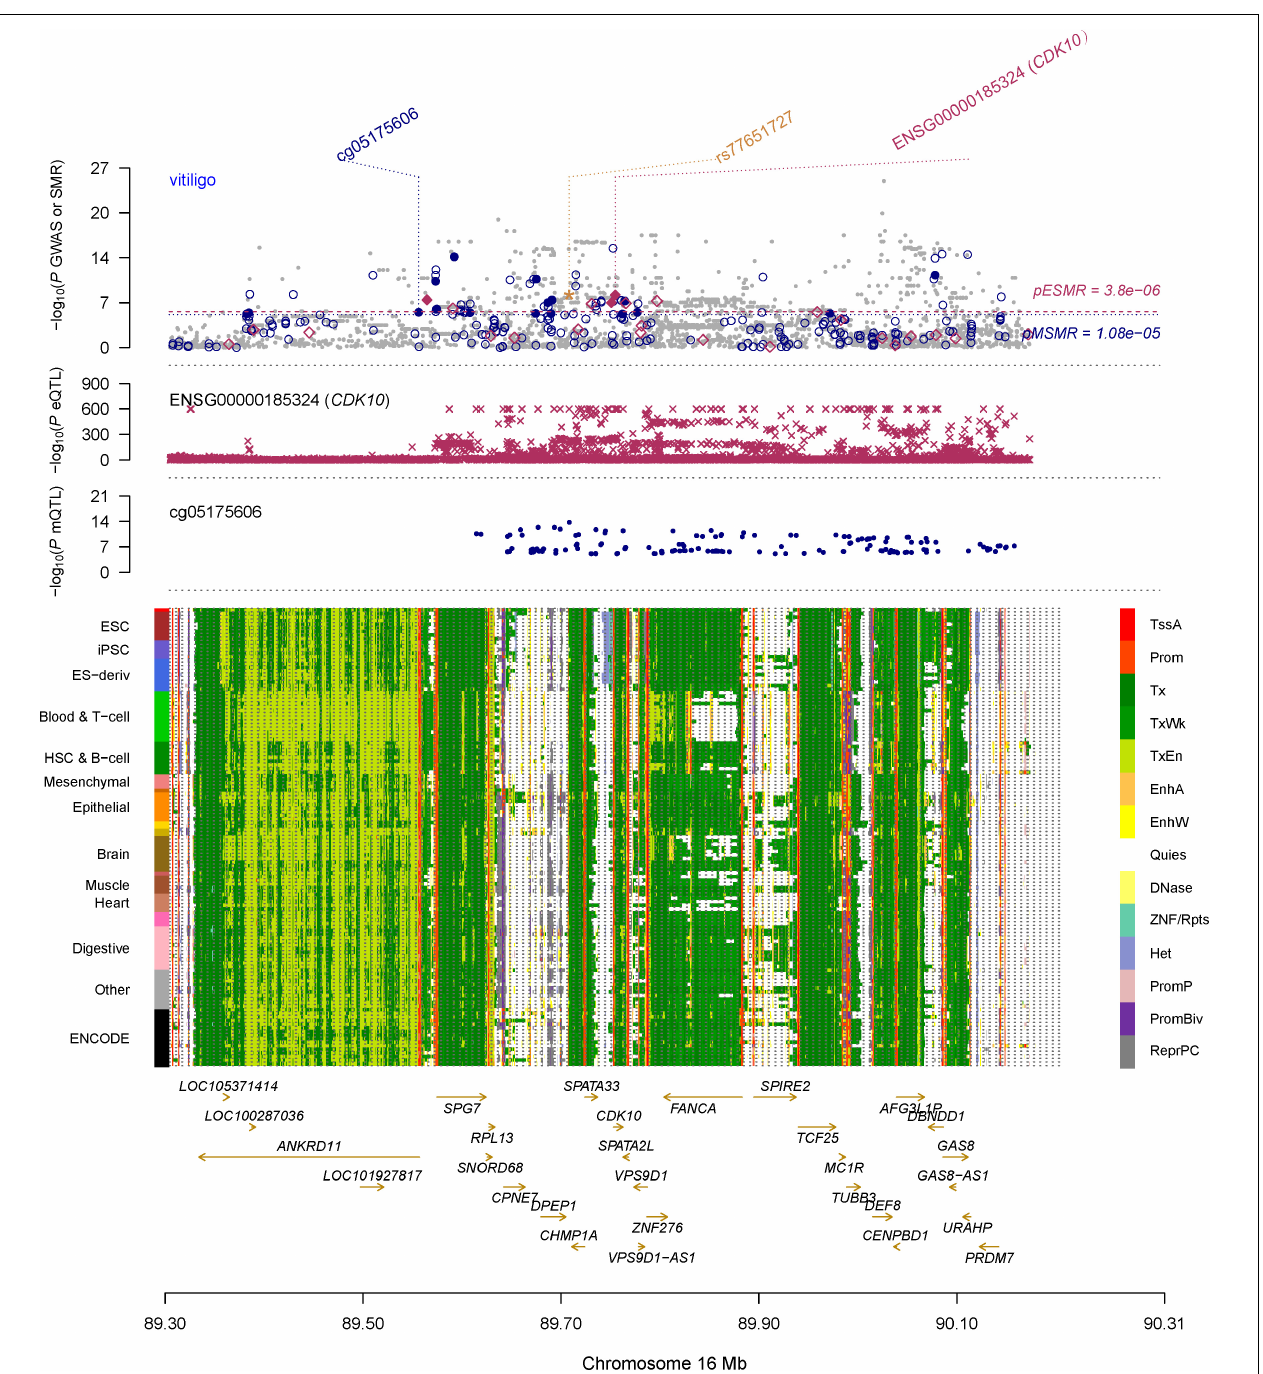
FIGURE 3 | Prioritizing CDK10 and cg05175606 for vitiligo. The top plot shows –log10( P -value) of SNPs from GWAS for vitiligo. The red diamonds and blue circles represent –log10( P -values) from SMR tests for associations of vitiligo with gene expression and DNAm probes, respectively. The solid circles and diamonds are the probes not rejected by the HEIDI test, the yellow star indicates the top-associated variant rs77651727 in the eQTL analysis of the CDK10 and the meQTL analysis of the cg05175606. The second plot shows –log10( P -values) from the eQTLGen dataset for associations of SNPs with gene expression probe ENSG00000185324 (tagging CDK10). The third plot shows –log10( P -values) from meQTL study for associations of the SNPs with DNAm probes (cg05175606). The bottom plot shows 14 chromatin state annotations (indicated by colors) of 127 samples from REMC for different primary cells and tissue types (rows). TSSA, active TSS; Prom, promoter, Tx, active transcription; TxWk, weak transcription; TxEn, transcribed and regulatory promoter/enhancer; EnhA, active enhancer; EnhW, weak enhancer; DNase, primary DNase; ZNF/Rpts, ZNF genes and repeats; Het, heterochromatin; PromP, poised promoter; PromBiv, bivalent promoter; ReprPC, repressed PolyComb; Quies,